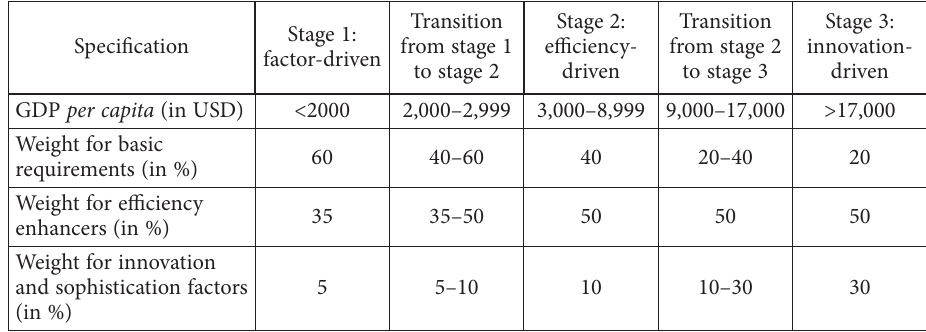
Table 2. Weights of the determinants of the competitive position of a country according to the stage of development (GDP per capita ) (source: WEF,